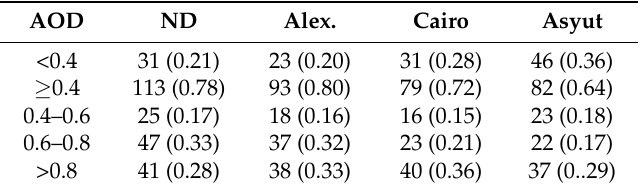
Table 5. Number of days in the 12-year record within the given AOD intervals over ND region and the three shown cities when the AOD over the WD falls in the same range. The ratio of this number to the total number of days when AOD data are available is shown between brackets. The 50 km domain around the city’s center is used. AOD ND Alex. Cairo